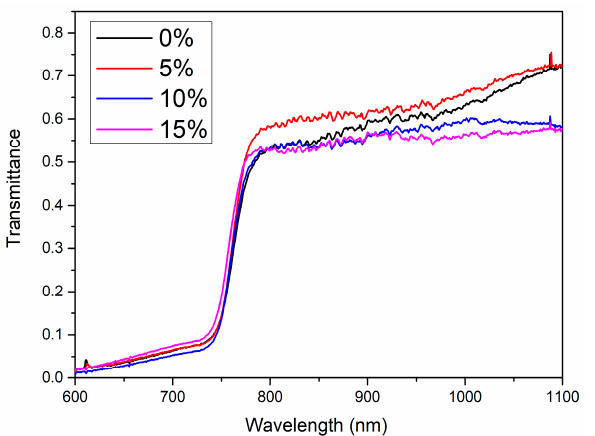
Figure 5. Optical transmittance spectra of the perovskite layers with a different percentage of cesium.